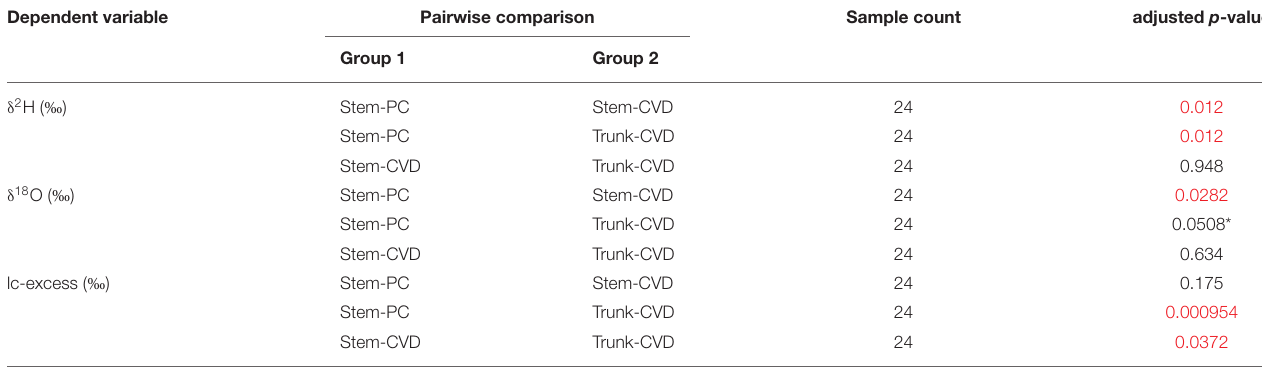
TABLE 3 | Summary table of results from Dunn’s test of Kruskal-Wallace ANOVA test with adjusted p -values using the Benjamini-Hochberg adjustment method. Dependent